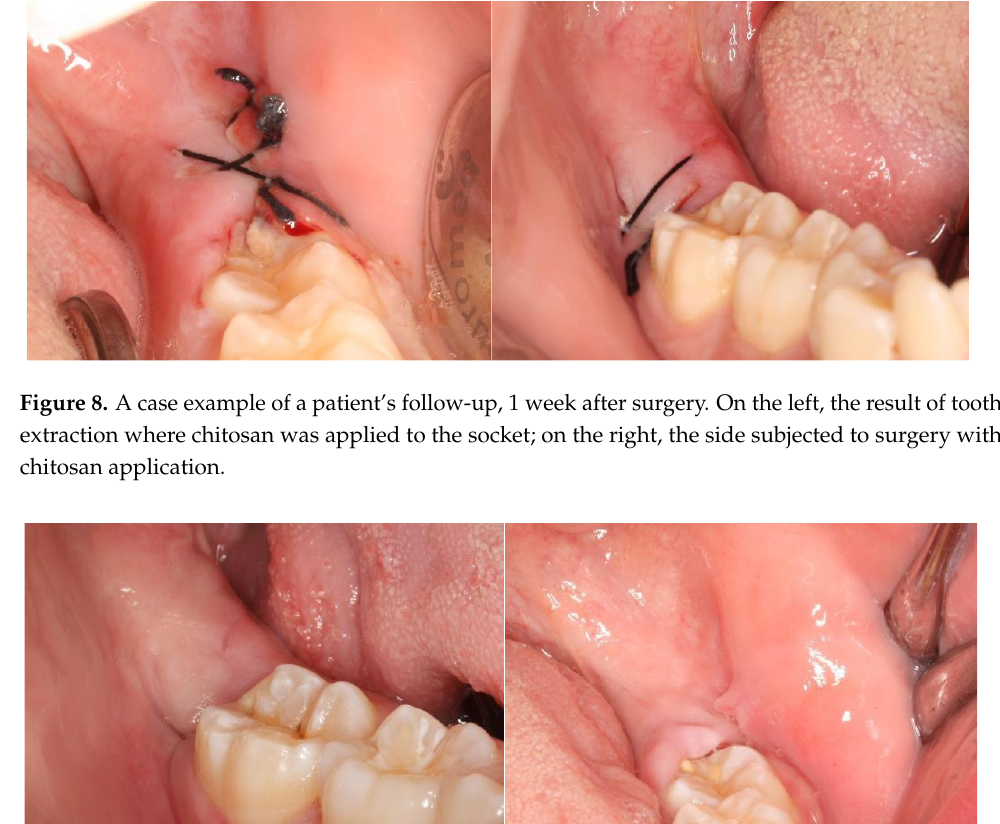
Figure 7. A case example of a patient’s follow-up, 72 h post-surgery. On the left, the result of tooth extraction where chitosan was applied to the socket; on the right, the side subjected to surgery with chitosan application.